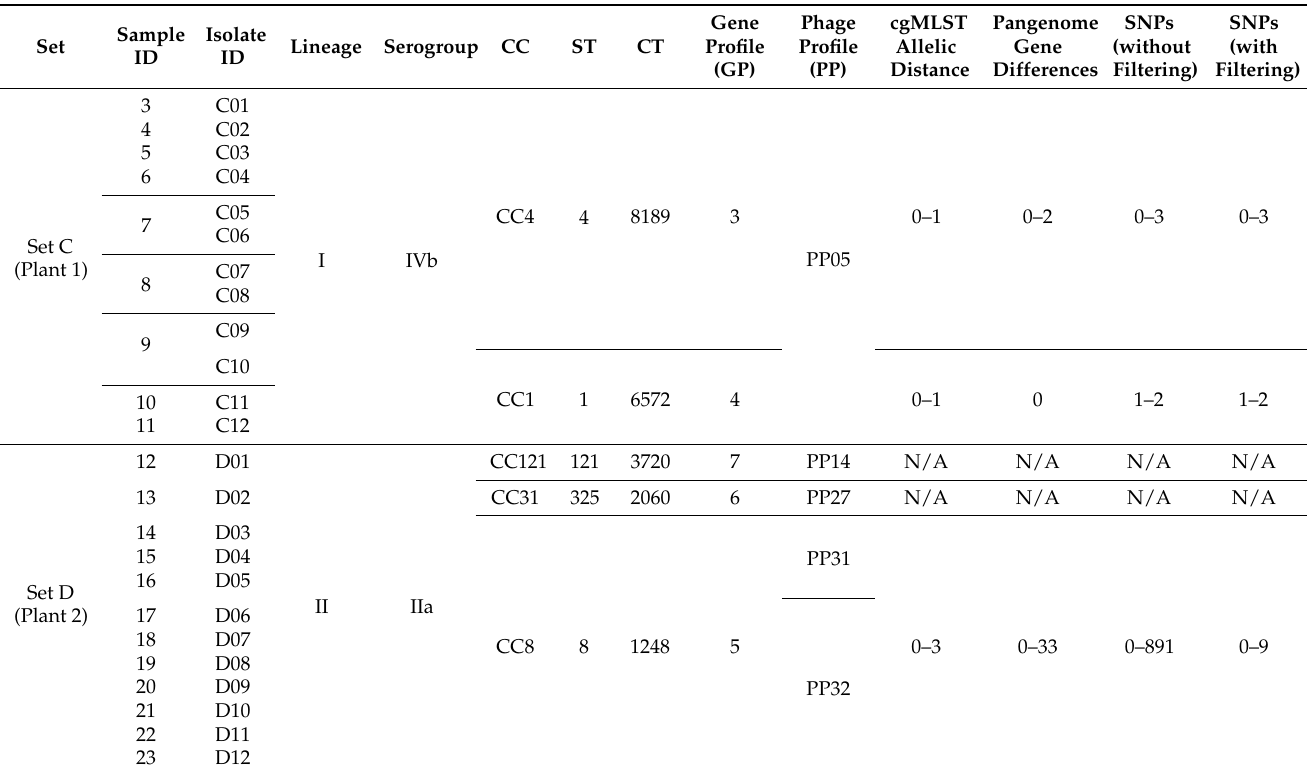
Table 3. Set isolates obtained from the same processing plants with indication of typing and screening results as well as the number of differences detected between the isolates by different analysis